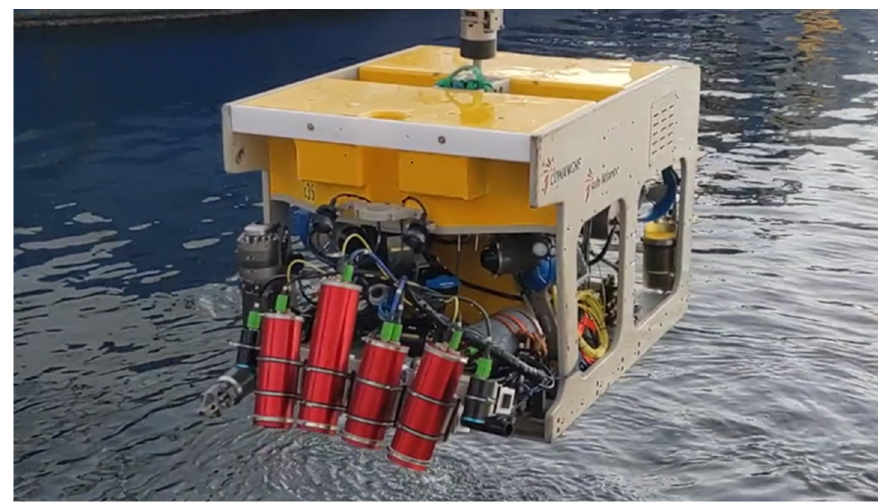
Figure 2. Underwater sensor system mounted on a ROV at immersion into water.